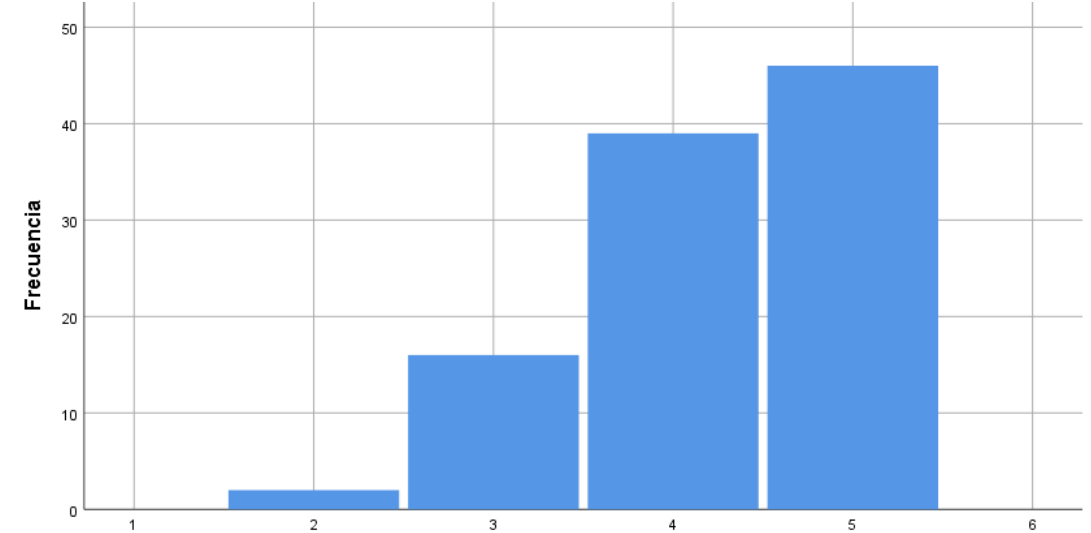
Figure 4. Degree of agreement about the actions required for improvement of the quality of attention to diversity.